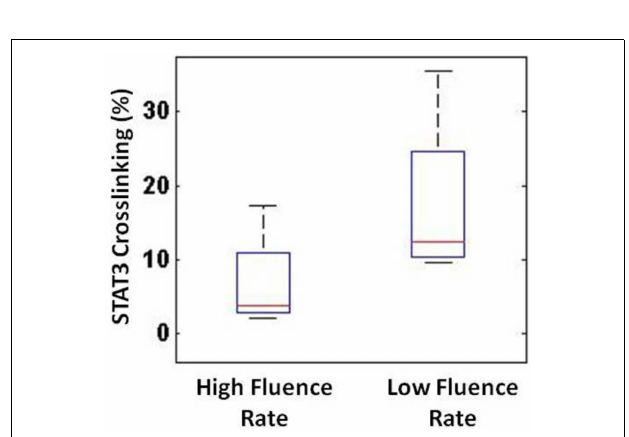
FIGURE 8 | STAT3 crosslinking showed a substantial difference between the high- and low-fluence-rate groups.